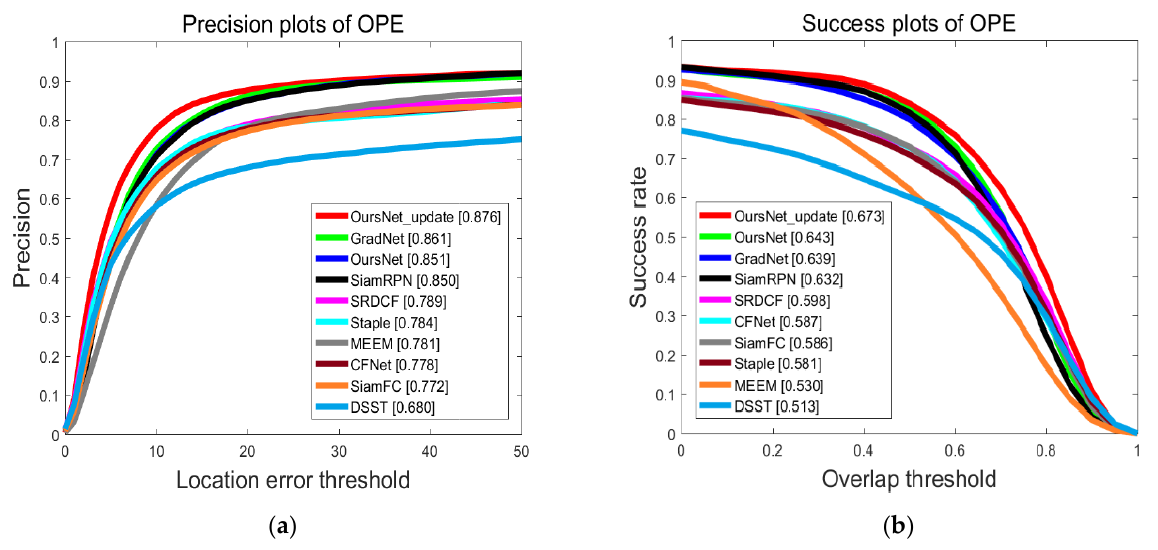
Figure 6. Performance evaluation results of different algorithms on OTB100 dataset. ( a ) Precision plots; ( b ) success plots.